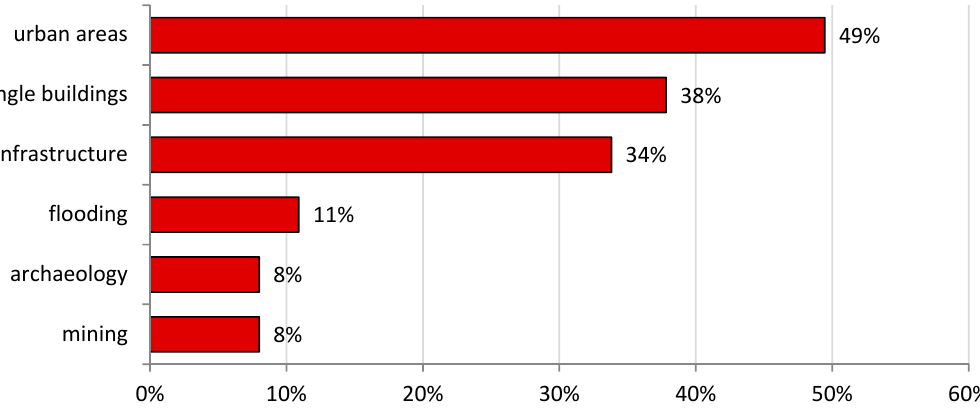
Figure 4. Thematic fields of anthroposphere-related TerraSAR-X proposals sorted by frequency, addressing the built-up area in general, individual buildings and infrastructure (e.g., dams, bridges, roads, railway tracks), the impact of natural disasters (in particular flooding), archaeology and manmade activities like mining.